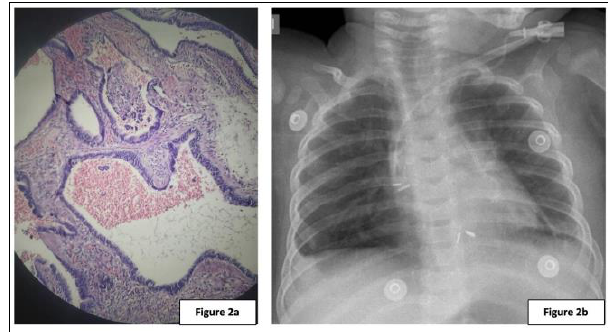
Figure 2: a) Lung lobe with dilatation of cysts lined by respirato- ry epithelium, without mucus cells and cartilage, and atelectasis of adjacent parenchyma. Consistent with CPAM type 2. b) Post- operative chest